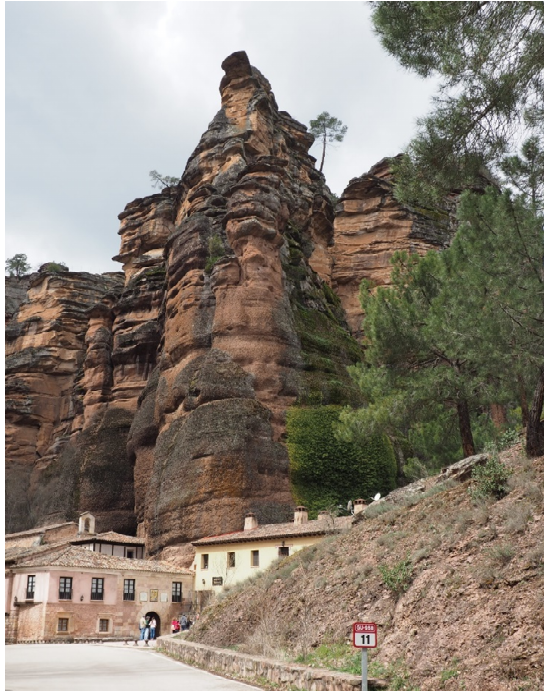
Figure 4. Barranco de la Hoz. Source: Mar í a del Carmen Cañizares